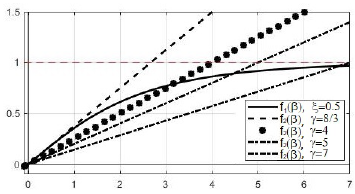
Figure 4. Graphics of the function f 1 ( β ) for ξ = 0 . 5 and function f 2 ( β ) for h = 0 . 02 and variuos γ . The root β 0 of Equation (2.8) exist.